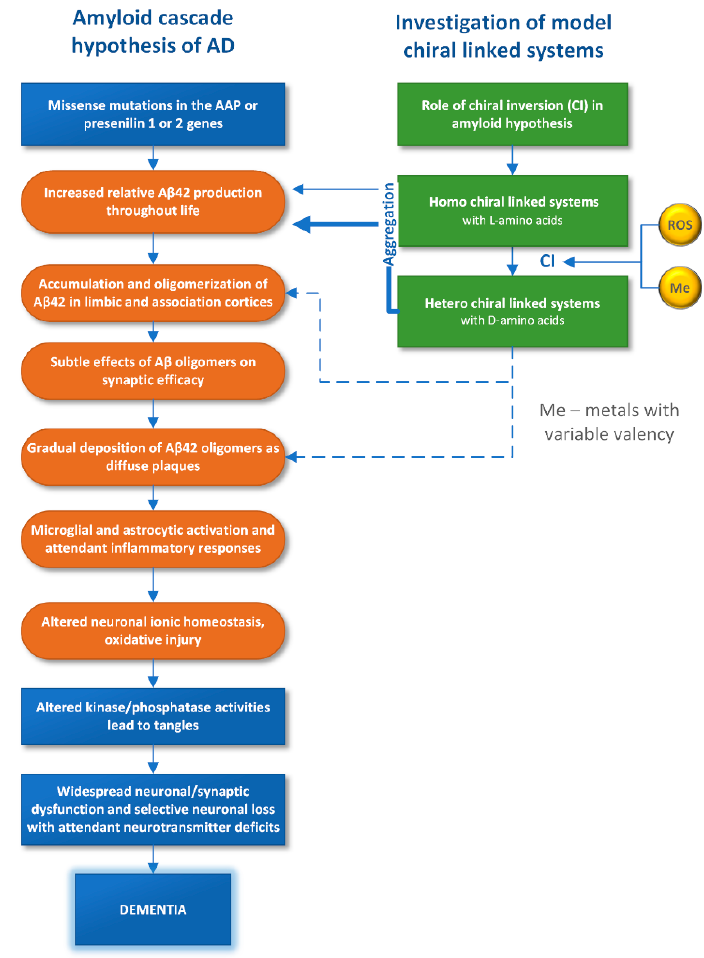
Figure 1. The amyloid cascade hypothesis for Alzheimer’s disease and results of the model systems investigation that provides insight into the role of D-amino acid participation in the amyloid A β 42 transformation.